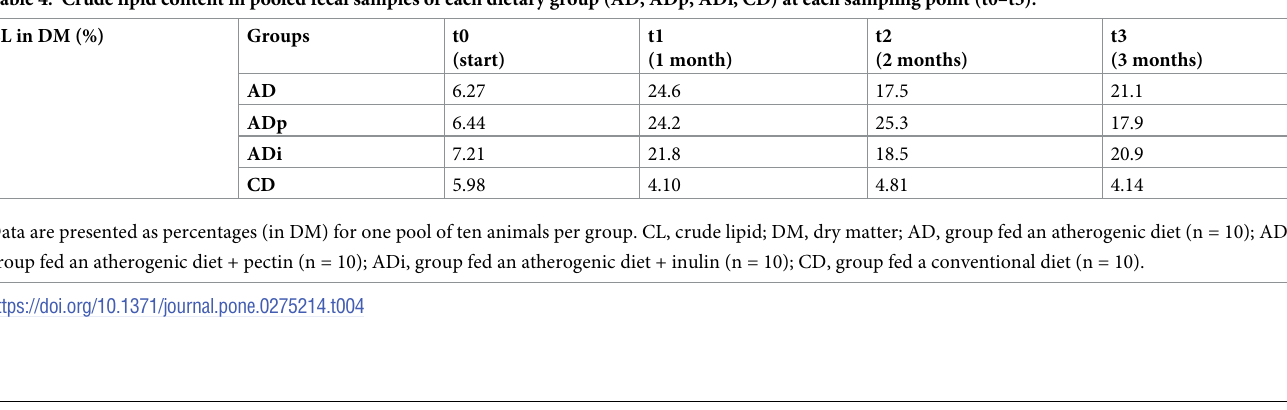
Table 4. Crude lipid content in pooled fecal samples of each dietary group (AD, ADp, ADi, CD) at each sampling point (t0–t3). CL in DM (%) Groups